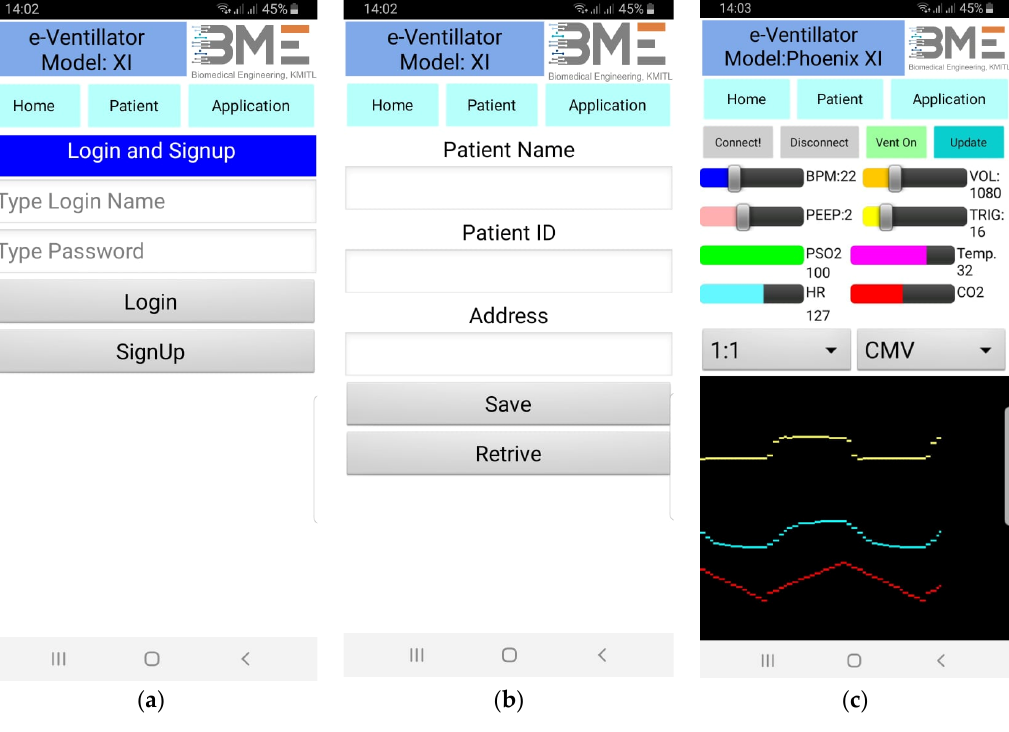
Figure 12. Application outlook on android phone: ( a ) login page, ( b ) database page, and ( c ) ventilator interfacing